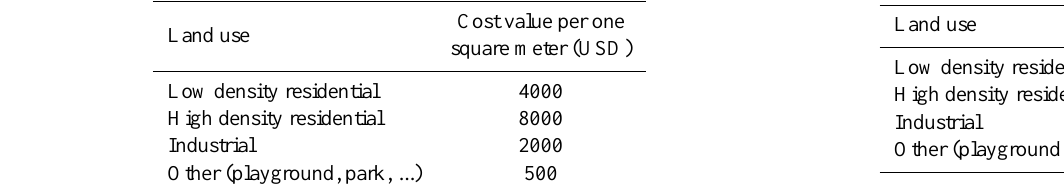
Table 4. Curve number (CN) of different land uses.